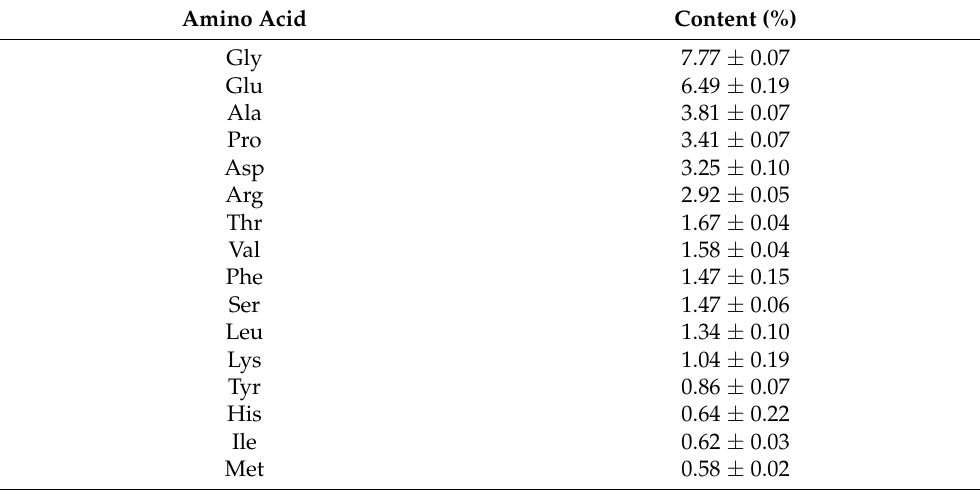
Table 1. Contents of amino acids in SCH.